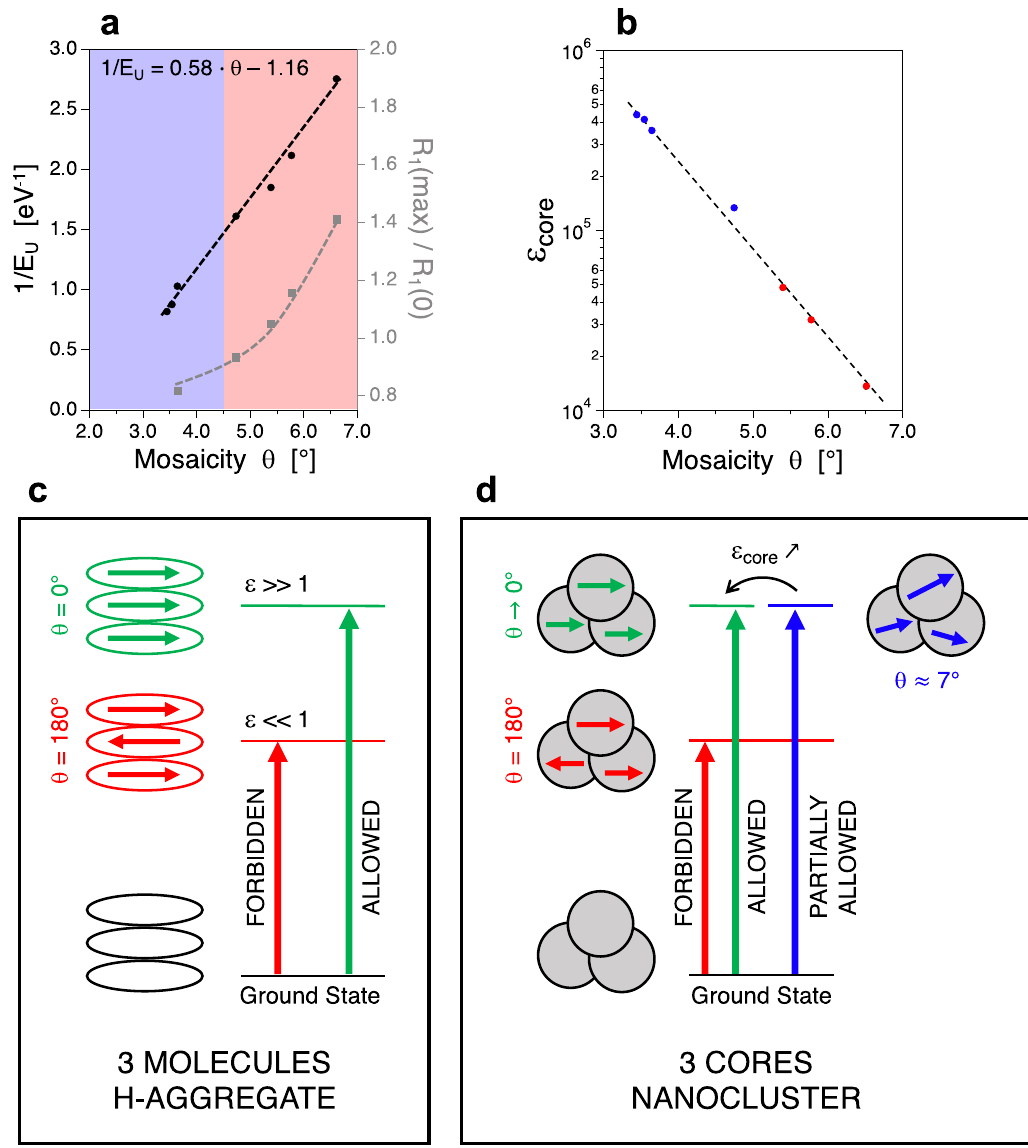
Fig. 5 Impact of mosaicity on the optical properties. a Defect-characteristic 1/E U values (black circles) and Néel contribution (R 1 (max)/R 1 (0), gray squares) as a function of mosaicity. b Evolution of the extinction coef fi cient of one core ( ε core = ε NP /N MC ) at 1064 nm with mosaicity. c Description of the optical theory for excitonic absorption in molecular H-aggregates. d Analogy of the molecular excitonic theory in the case of multi-core nanoclusters such as